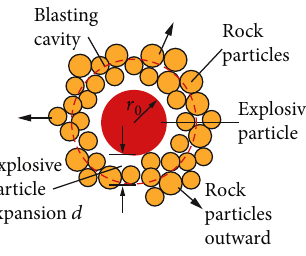
Figure 2: Schematic diagram of blasting load applied by particle expansion